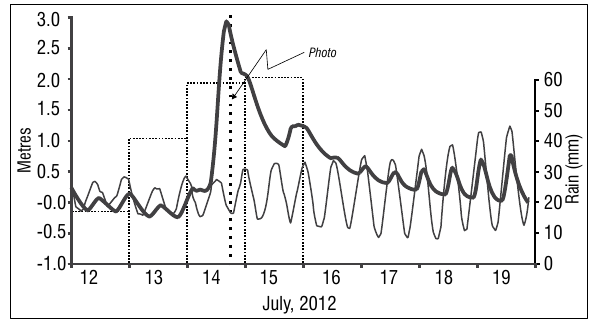
Figure 9: Hourly sea level data from Mossel Bay (light line), hourly water level data from the N2 gauge (dark line), and daily rainfall records (dotted line). The time at which the photo in Figure 11 was taken is shown.